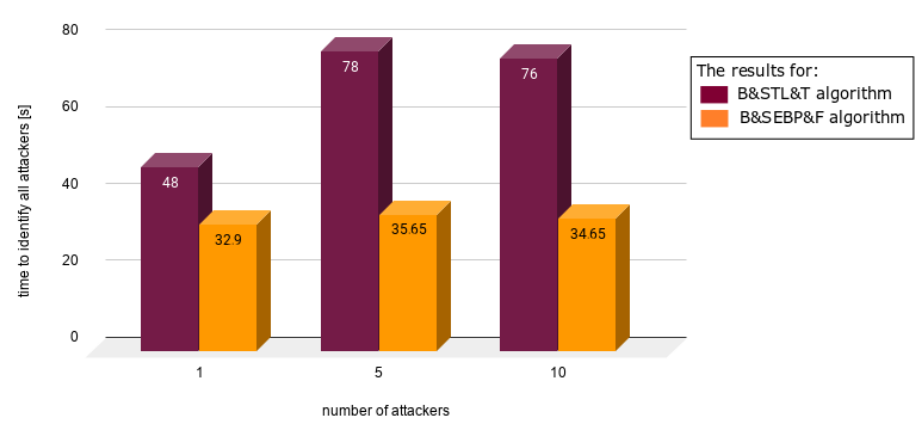
Figure 10. Results from experiments no. 1, 2, and 3 (experiments can be found in Tables 3–7).